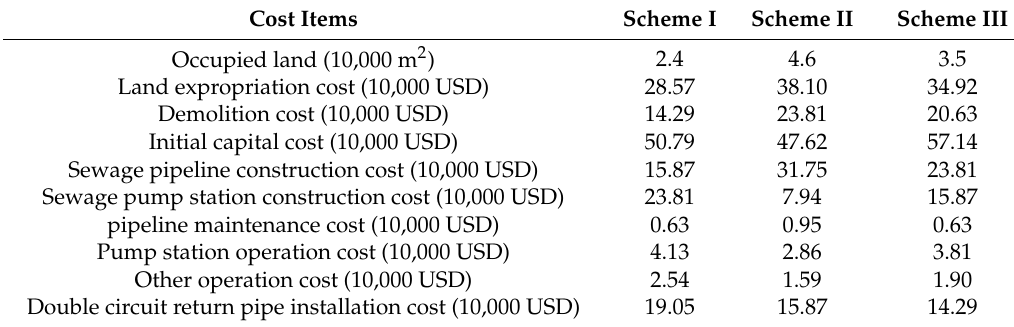
Table 1. Cost schedule of all